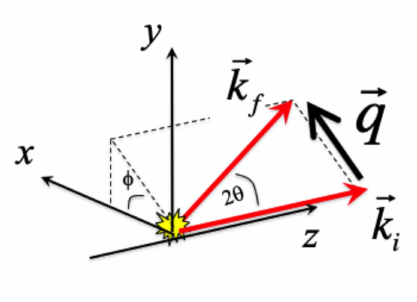
Figure 5. Scattering geometry and definition of scattering wave number q